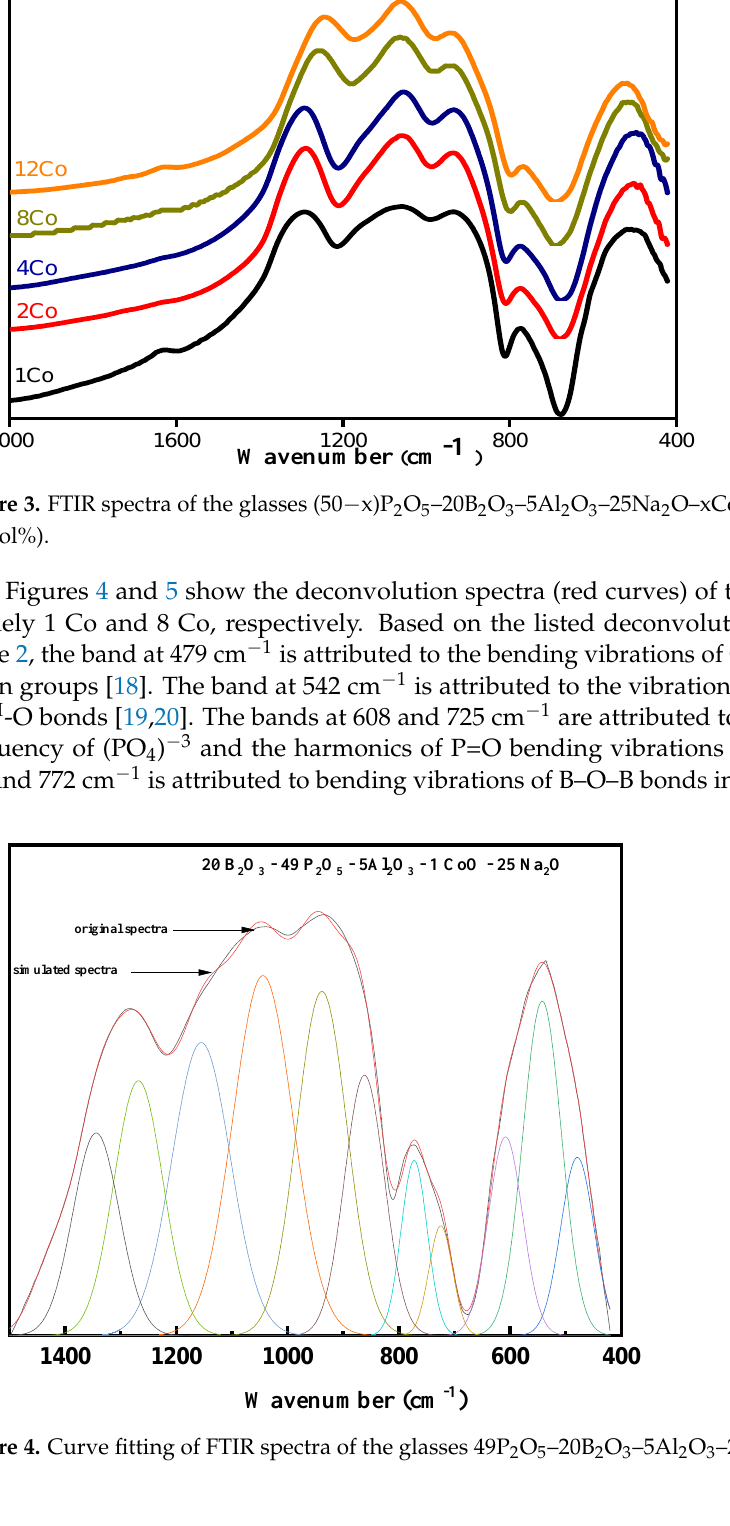
Figure 5. Curve fitting of FTIR spectra of the glasses 42P 2 O 5 –20B 2 O 3 –5Al 2 O 3 –25Na 2 O–8CoO. Table 2. Deconvolution parameters of the glasses and their assignments. C is the center of the band, and A is the relative area (%) of the band. 1Co